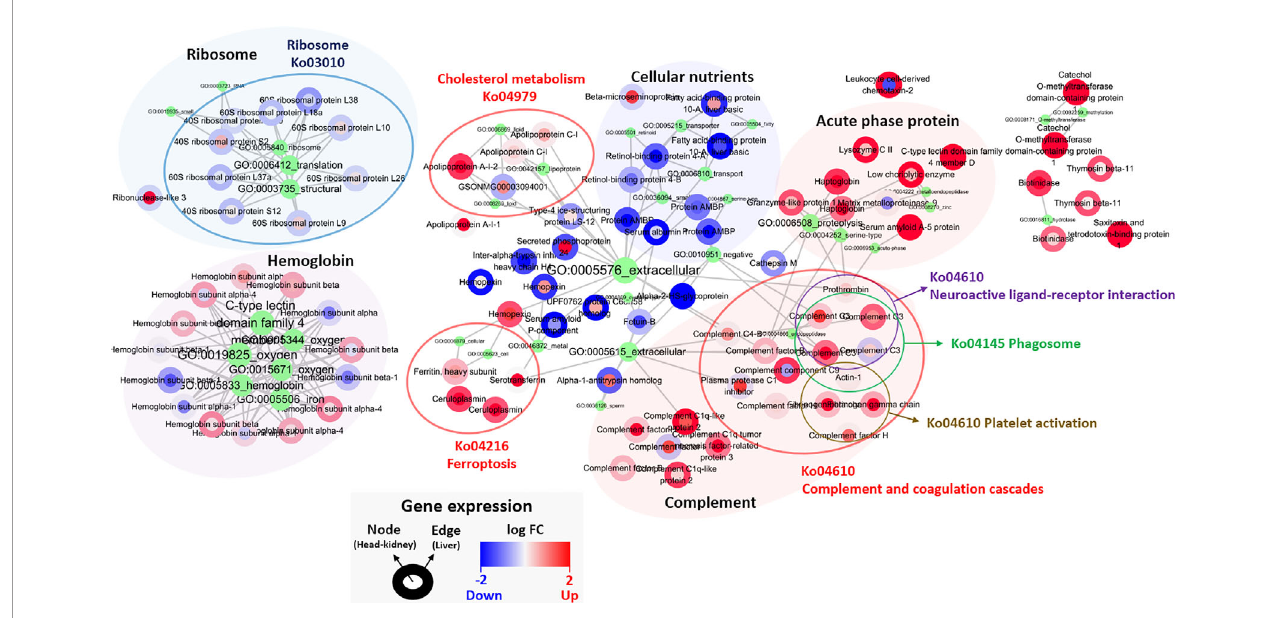
FIGURE 5 | Classi fi ed genes from PLDA calculation. Nodes and edges in the circles color are the areas for the gene expression in the head-kidney and liver, respectively, and red and blue color show up- and down-regulated genes. The green circle represents GO pathway, and its size and letters indicate the number of genes belonging to each GO pathway. The gene(s) belonging to GO pathway(s) is marked by gray lines. Each gene expression is described in Table S9